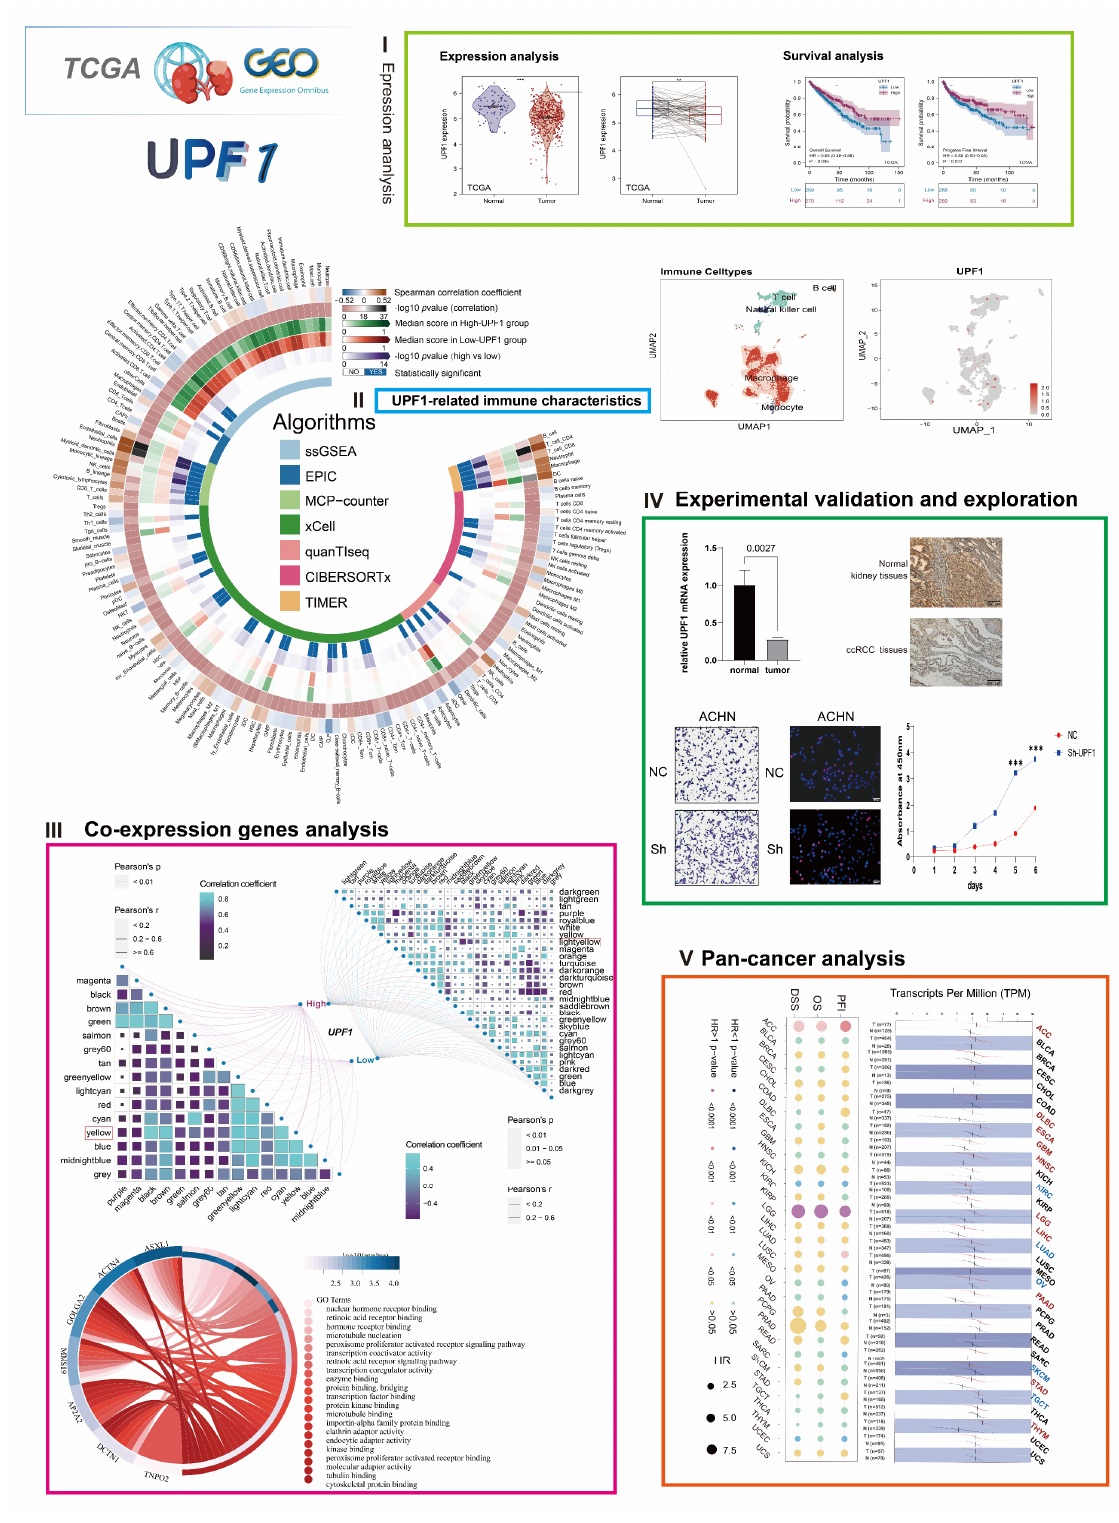
Figure 1. The flow-process diagram of the current study. ( I ) Expression analysis. ( II ) UPF1-related immune characteristics. ( III ) Co-expression genes analysis. ( IV ) Experimental validation and explo- ration. ( V ) Pan-cancer analysis of UPF1. ** p < 0.01 and *** p <